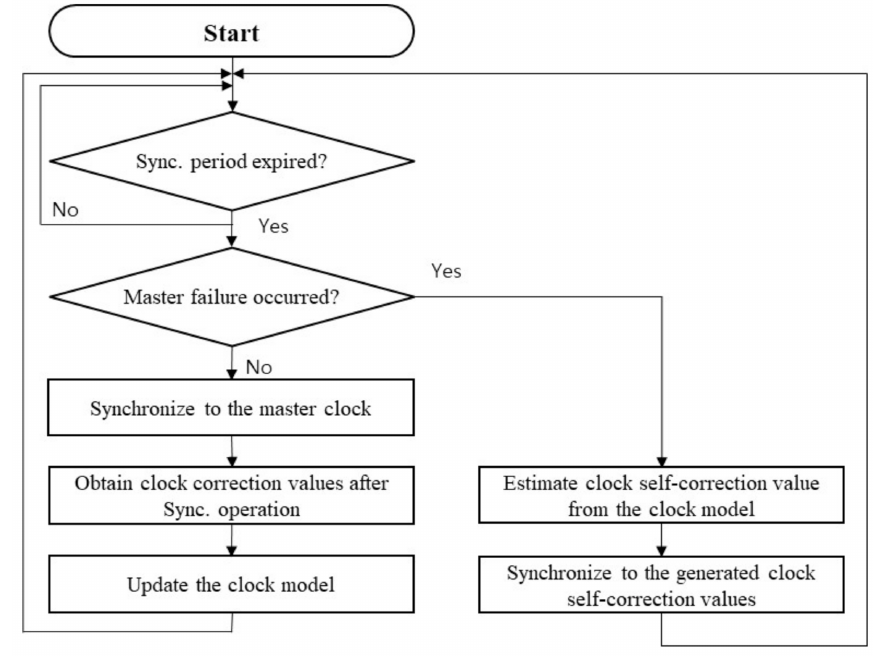
Figure 3. The flow chart of the proposed clock rate self-correction